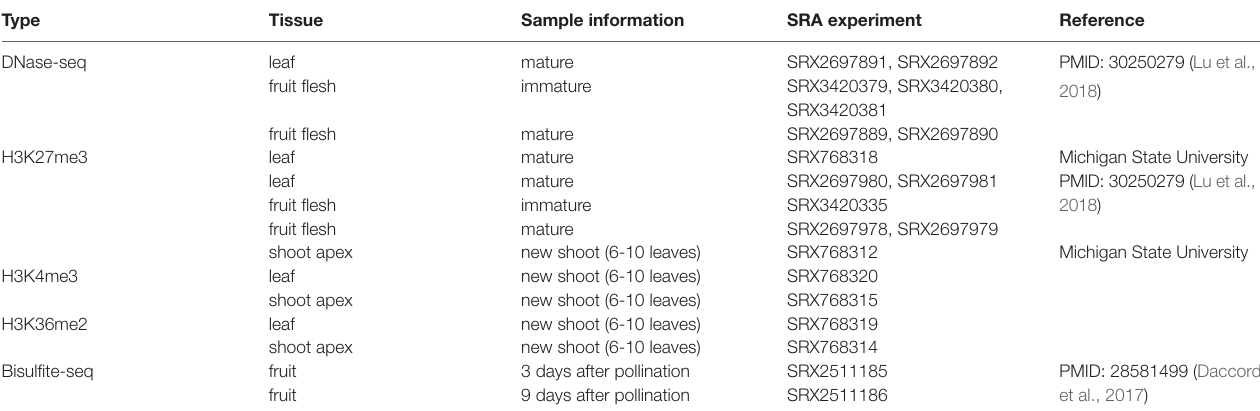
TABLE 2 | Epigenomic data